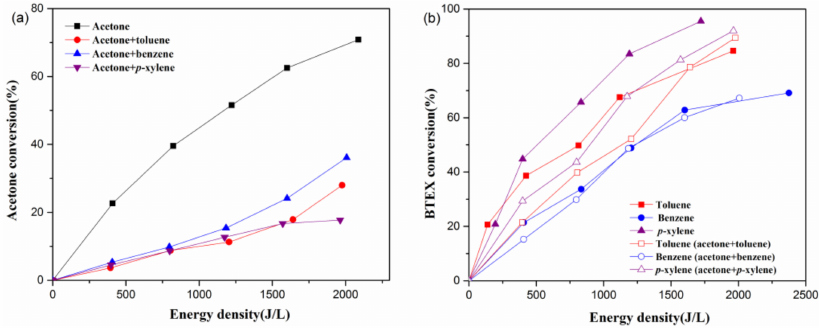
Figure 2. Effects of energy density on acetone ( a ) and BTEX conversion ( b ). Reaction conditions: acetone: 250 ppm, BTEX: 50 ppm, relative humidity (RH): 50%, and total flow: 2 L/min.